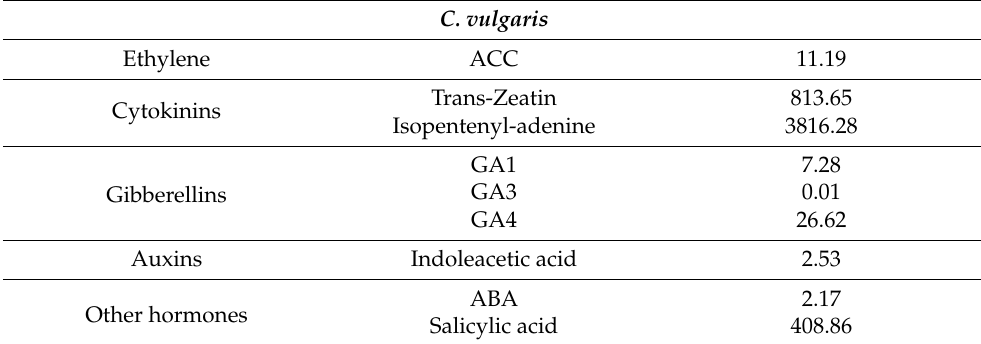
Table 1. Hormone content of the untreated microalga (ng g − 1